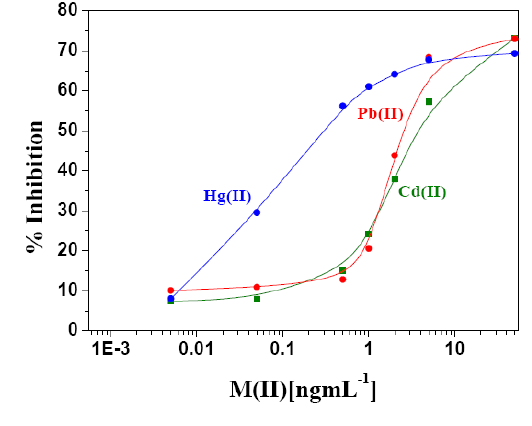
Figure 5 . Inhibitory effect of Hg(II), Cd(II) and Pb(II) concentration on AlOx activity at incubation time 20 min. in 96 well plate